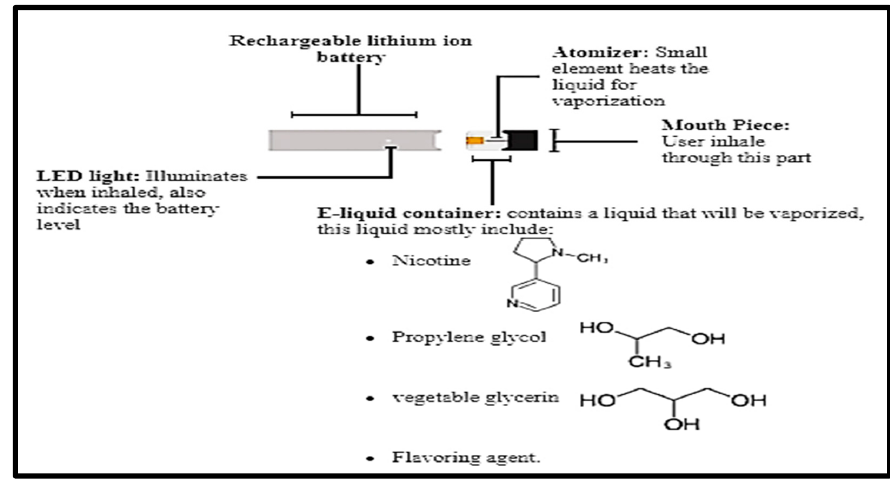
Figure 1. Electronic cigarette components.